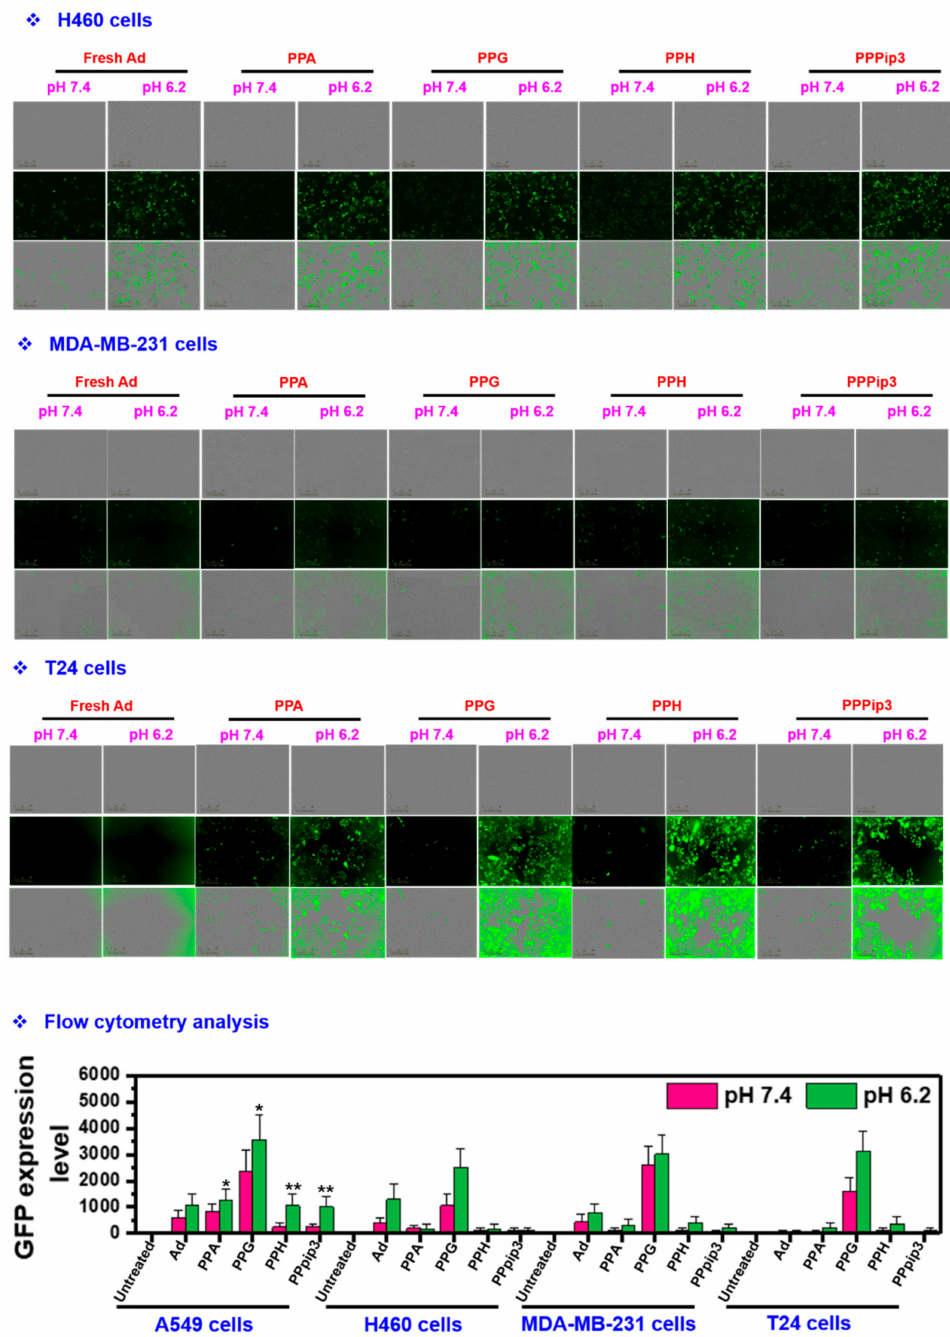
Figure 10. Transduction efficiency of PPA-dE1/GFP-Ad, PPH-dE1/GFP-Ad, PPG-dE1/GFP-Ad, and PPPip3-dE1/GFP-Ad conjugates in different pH conditions (pH 7.4 and pH 6.2). Fluorescence images of CAR-positive and CAR-negative cancer cells exposed to different copolymer–Ad conjugates prepared using copolymer ratio of 5 × 10 4 and 20 MOI dE1/GFP-Ad. To observe the transduction, cells were exposed to copolymer–Ad conjugates for 60 min, subsequently washed, and incubated for 48 h. The GFP images were photographed using Incucyte Live-Cell imaging system. GFP expression levels were measured by flow cytometry analysis. The error bars in the graph represent standard deviation ( n = 3). ** p < 0.005 and * p < 0.01 compared with